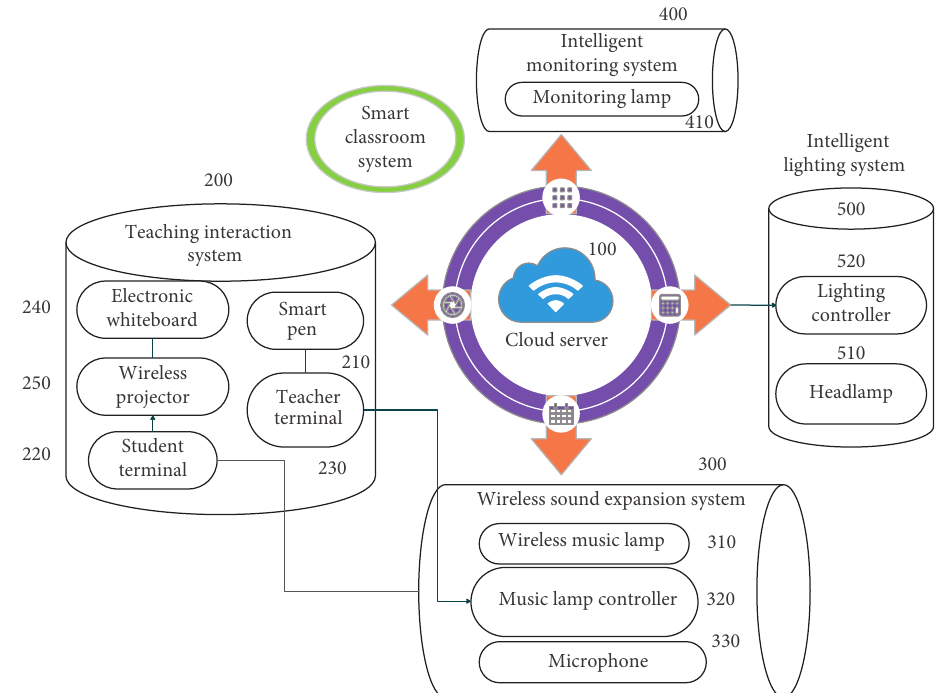
Figure 1: Multimedia-assisted music teaching system based on AI technology.